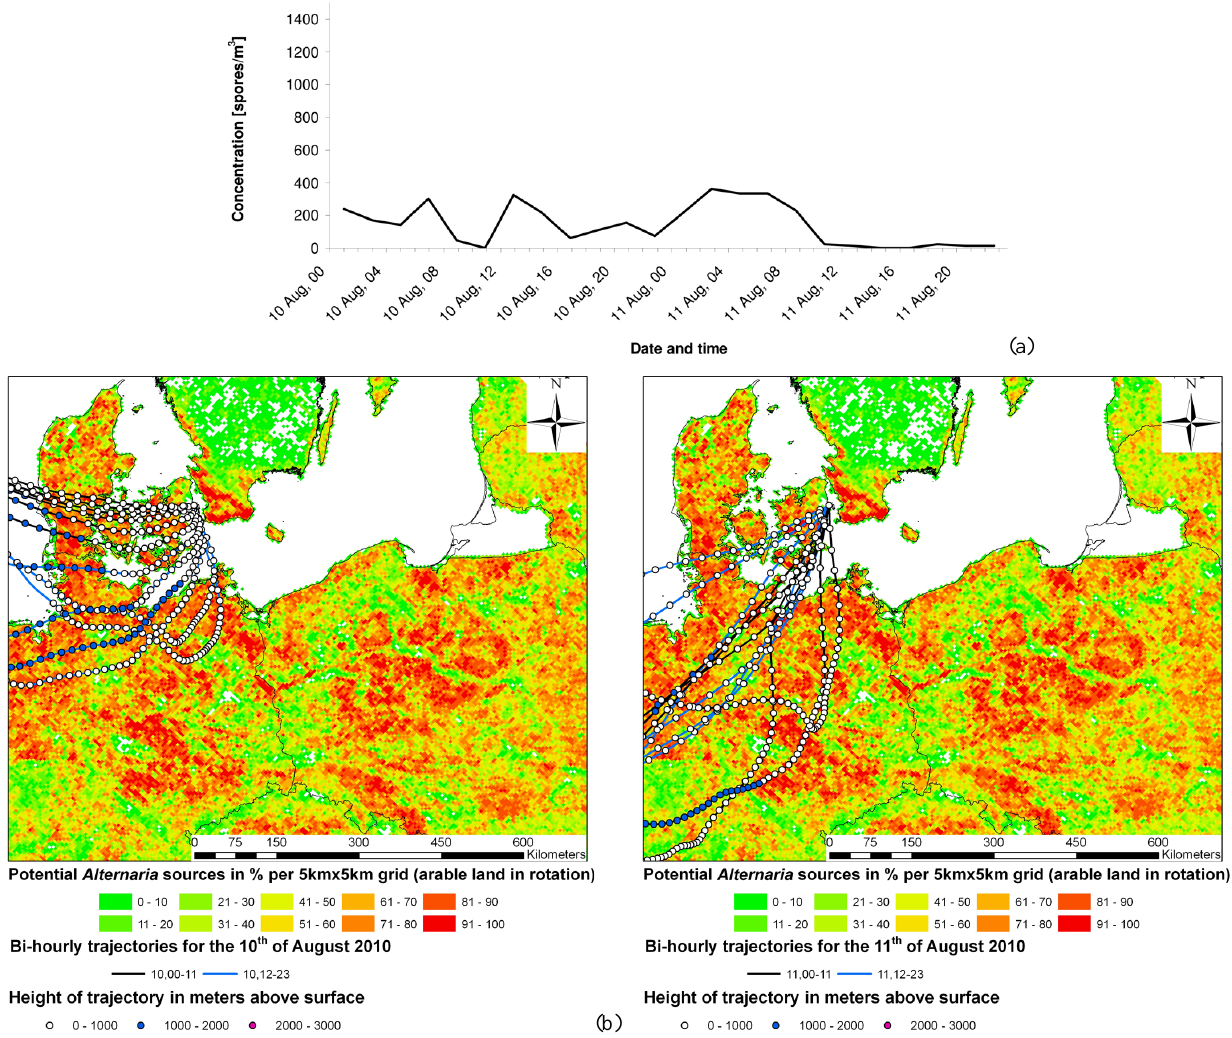
Fig. 4. (a) Bi-hourly variation in Alternaria spore concentrations (sporesm − 3 ) obtained in Copenhagen 10 and 11 August 2010. Back- trajectories arriving at the spore trap in Copenhagen: (b) 10 August; (c) 11 August. The distance between two dots on a trajectory corresponds to one hour of atmospheric